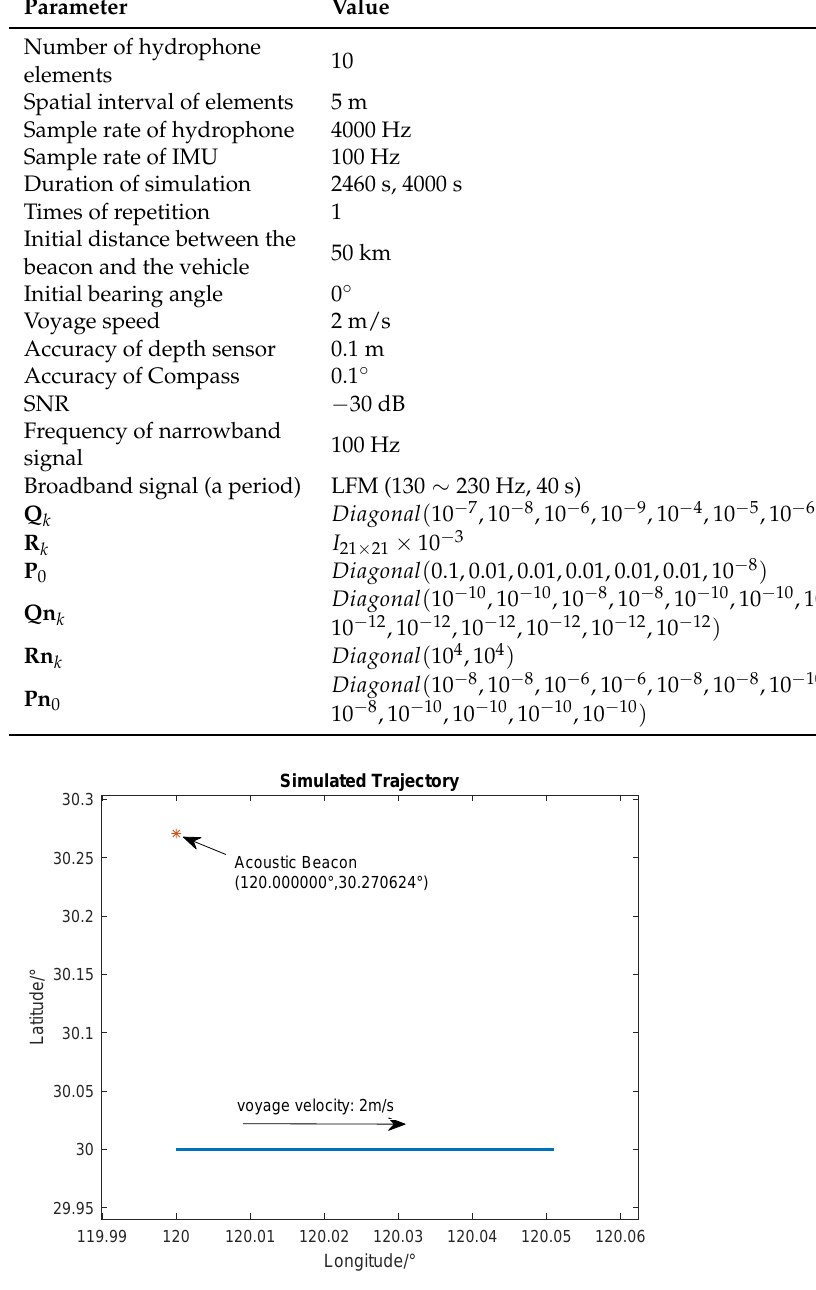
Figure 8. The simulated